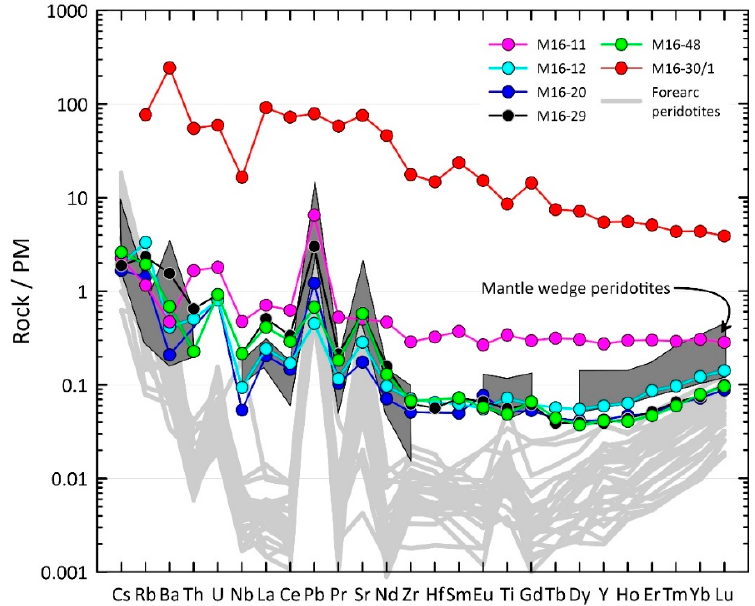
Figure 7. Primitive mantle-normalized [52] multi-element patterns in the bulk-rock Alag Khadny peridotites and in the dike of calc-alkaline basalt M16-30/1 cutting the peridotites. Forearc peridotites are from [41], and mantle-wedge peridotites are from [13].